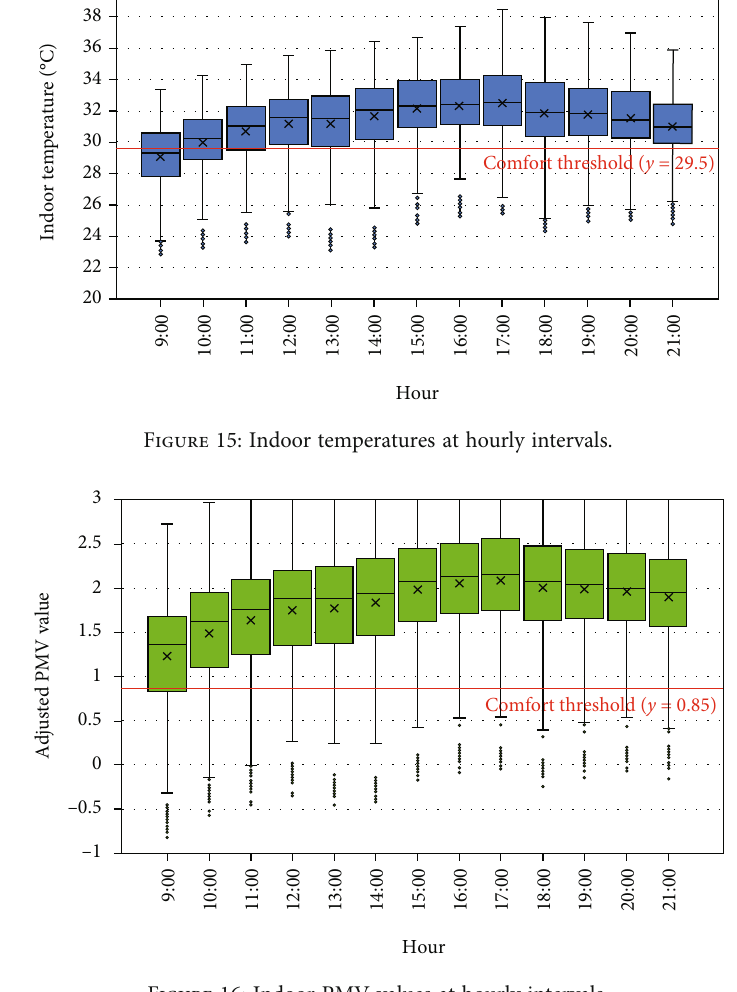
Figure 16: Indoor PMV values at hourly